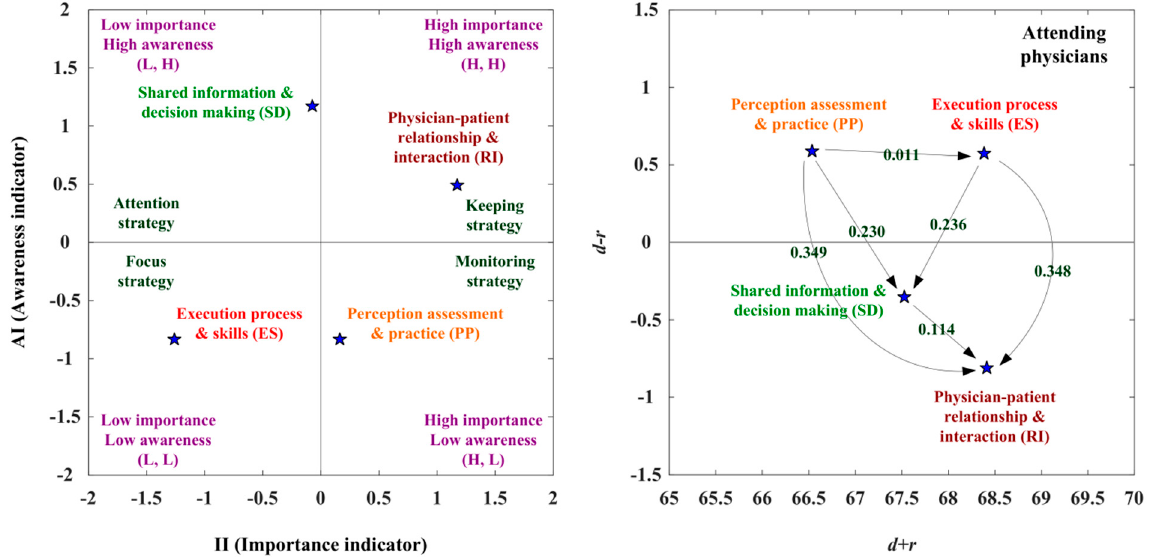
Figure 3. The SDM competency development map for attending physicians. Table 6. The adoption strategy of SDM competency development for attending physicians.